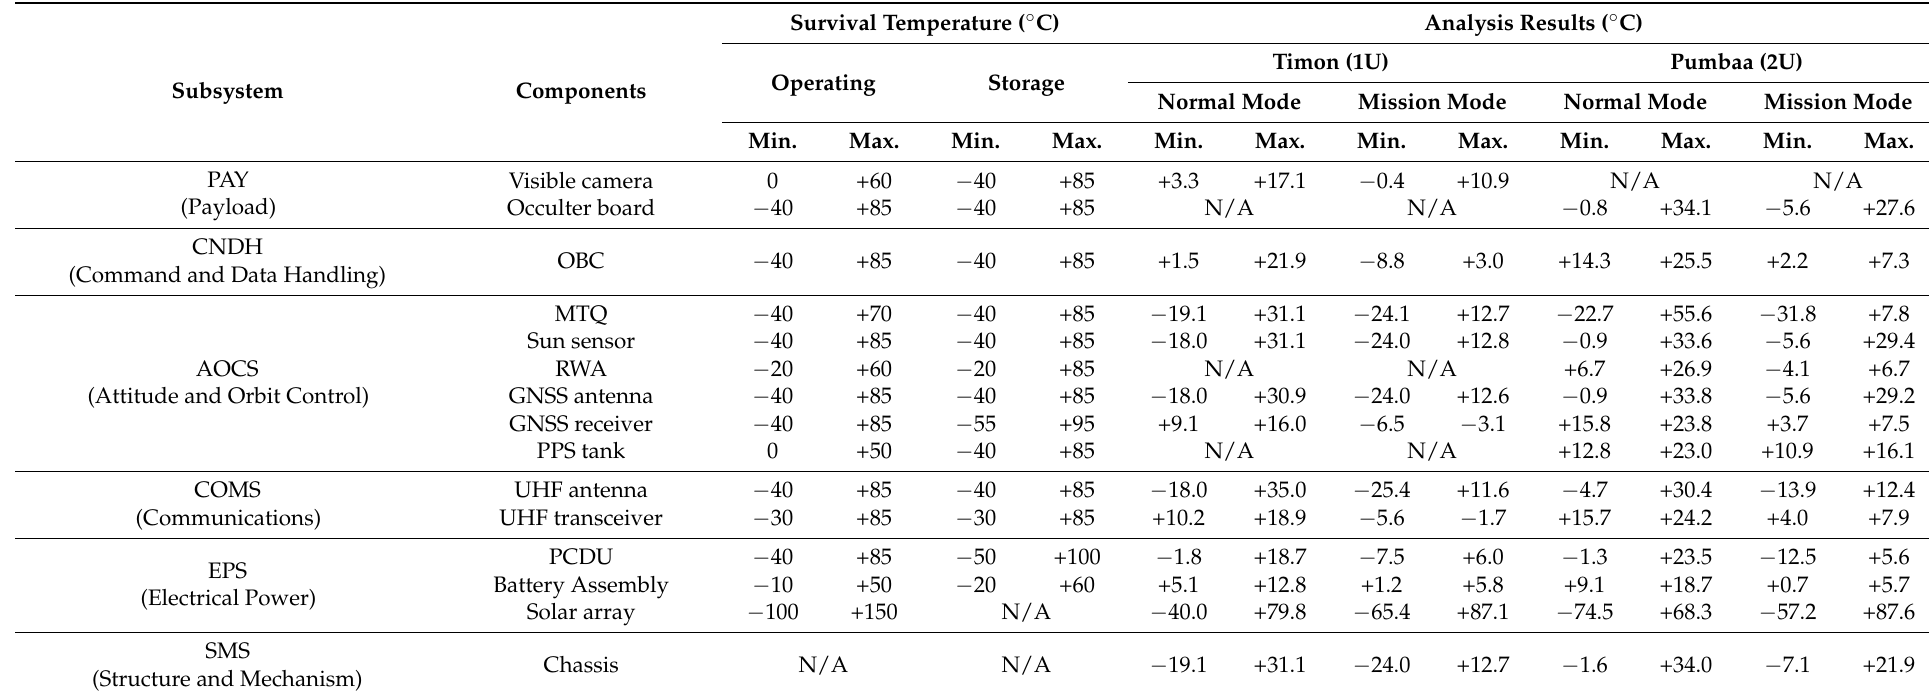
Table 6. Survival temperature of main components and thermal analysis